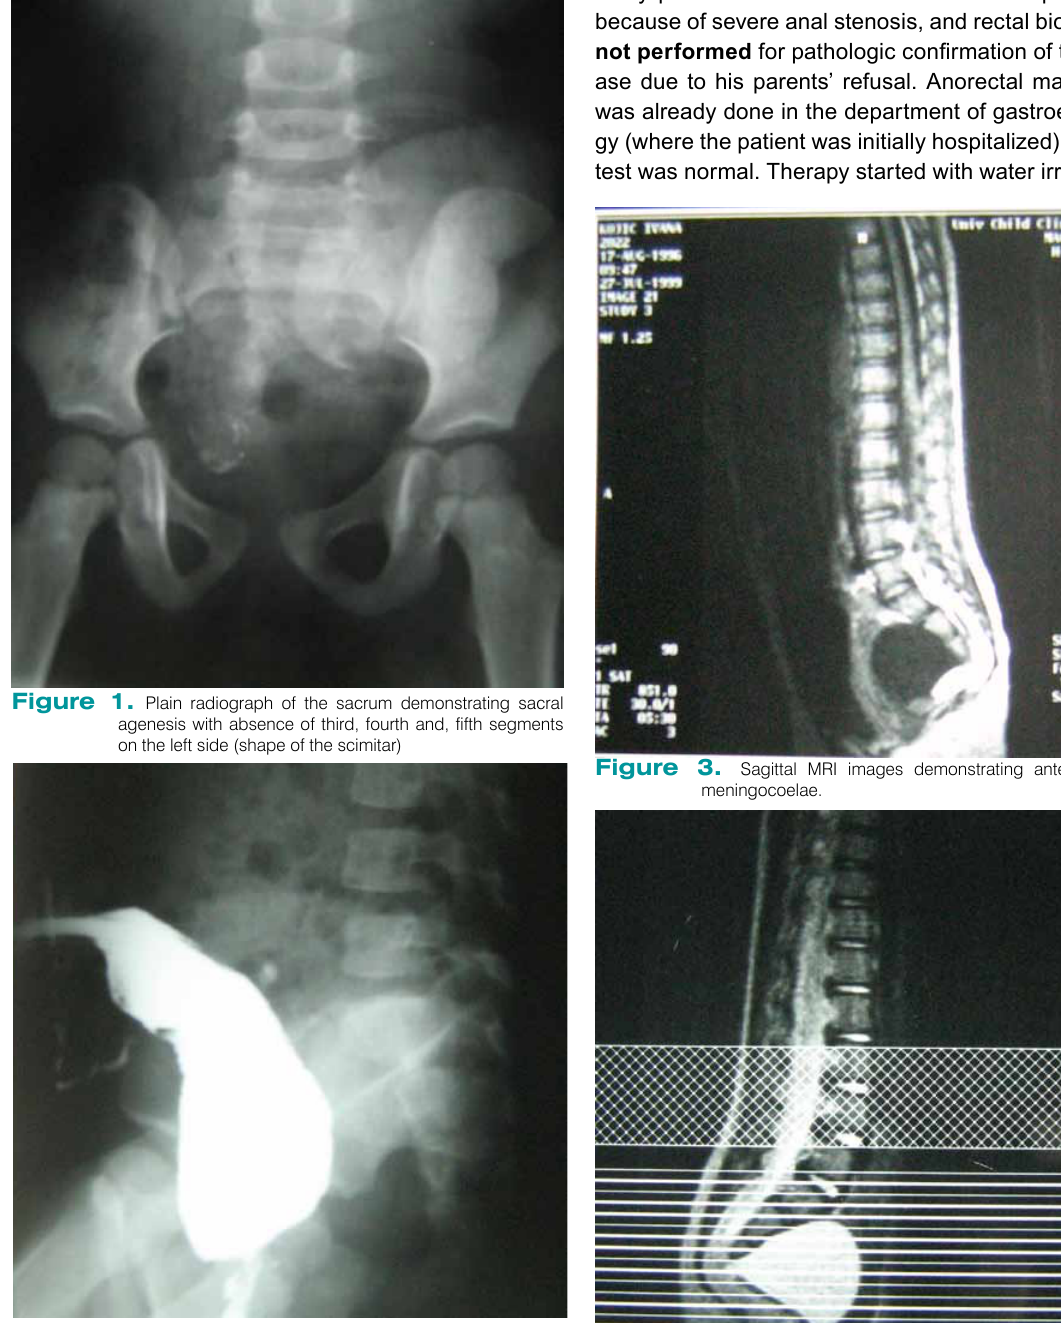
Figure 2. Distal colostogram. Barium enema study. Severe anorec- tal stricture suggested the presacral mass. Space between rectum and sacrum is increased Figure 4. MRI demonstrating presacral mass, 8 cm in diameter.